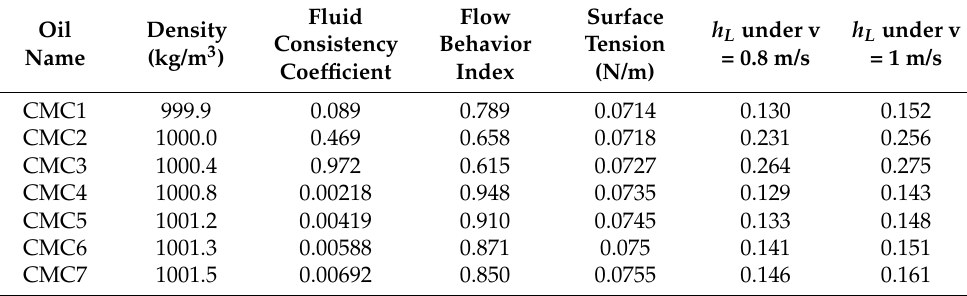
Table 2. Physical properties of non-Newtonian oil c 41] and h L.